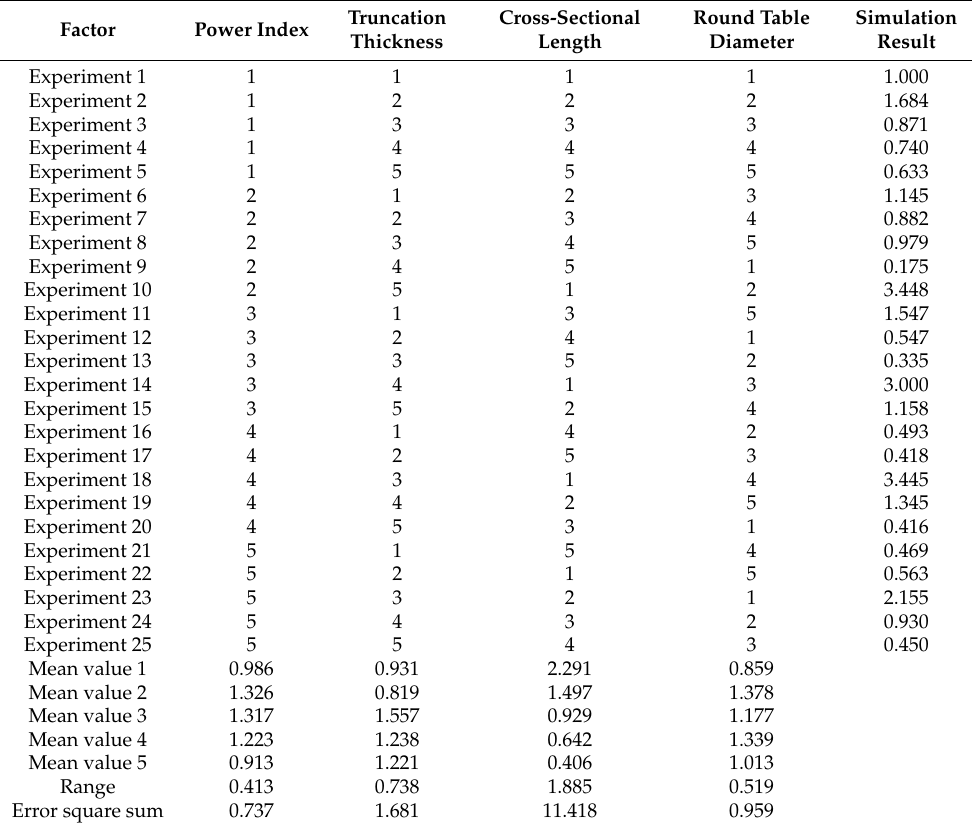
Table 6. Visual analysis of ABH structural